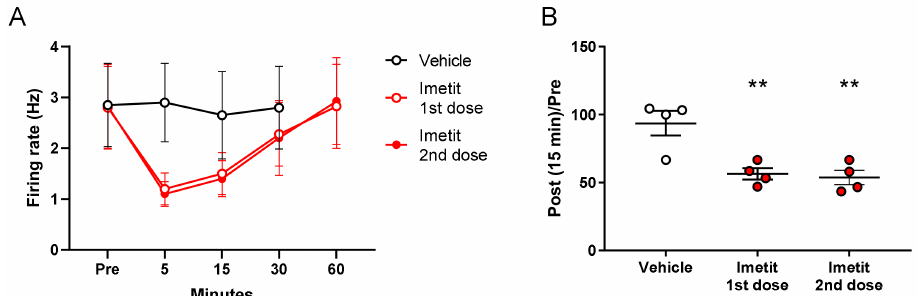
Figure 4. An electrophysiological system was used to perform two consecutive assessments with a 2 h interval. Imetit (1.0 mg/kg) significantly suppressed mechanical stimuli-evoked firing at the first and second doses: ( A ) temporal changes in the firing rate and ( B ) the post and pre-administration ratios. Data are presented as the mean ± S.E.M. ** p < 0.01 vs. vehicle group analyzed using Dunnett’s multiple comparison test (n =